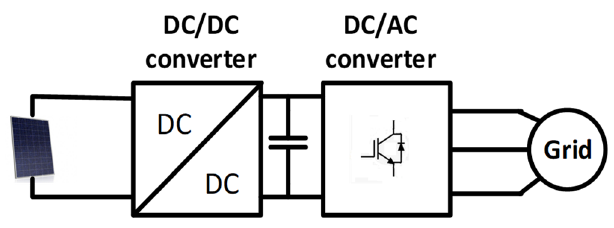
Figure 1. A two-stage PV grid-connected system.